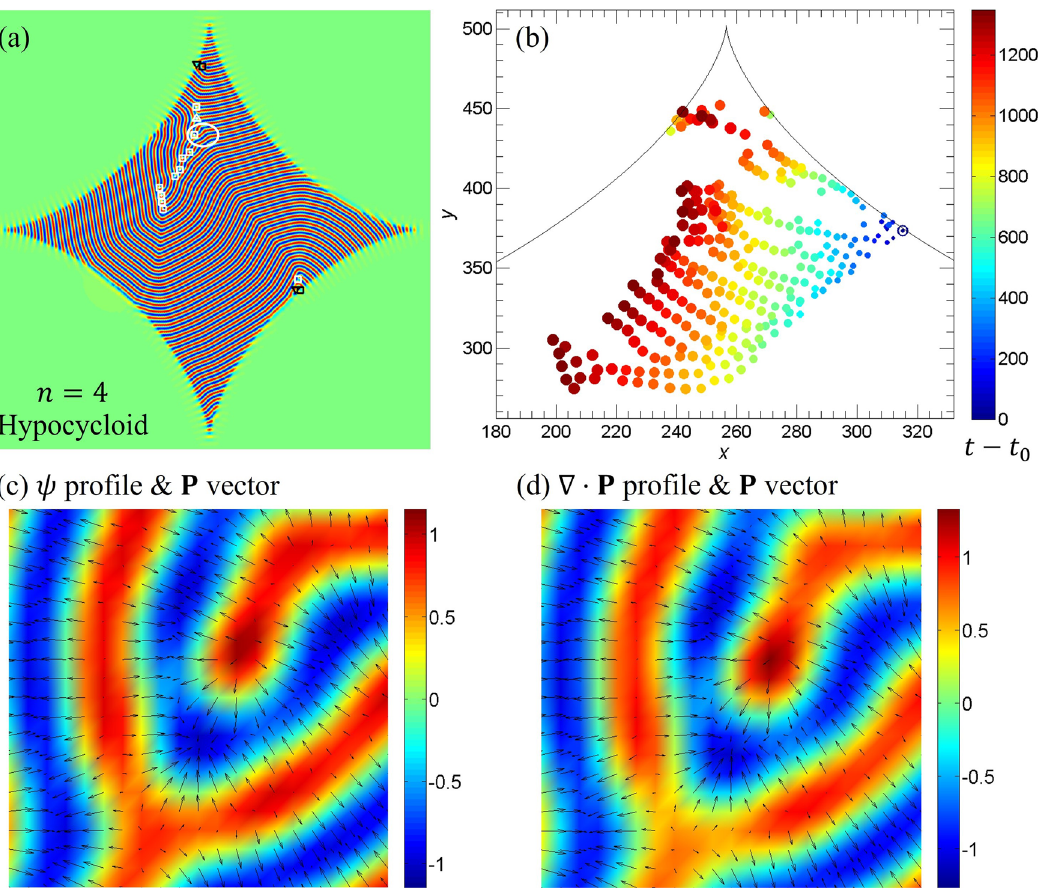
Fig. 5 Spatial pro fi les of ψ and S fi elds and defect trajectories in hypocycloid cavity. a Sample simulation snapshot of the density fi eld ψ pro fi le for a 4-cusp hypocycloid (astroid) cavity at v 0 = 0.31, with the labeling of defects. b Trajectories of defects in the upper part of the cavity, starting from a single defect (circled on the right) nucleated at the boundary at time t 0 = 198,650 up to the snapshot of ( a ) at t = 2 × 10 5 . Larger symbol size corresponds to later time, and samples for different time are also color-coded according to the color bar given on right. The hypocycloid boundary curve is also plotted. The corresponding time evolution of the pattern and defects can be found in Supplementary Movie 5. c Enlarged portion of the circled region in ( a ), with black arrows indicating the polarization vector fi eld P and the color bar showing the scale of density fi eld ψ . d The corresponding spatial pro fi le of the divergence fi eld S = ∇ ⋅ P , with P vector also shown as arrows and the scale of S fi eld indicated by the color bar. Note a small phase shift of this S fi eld pro fi le with respect to the ψ pro fi le in ( c ), which corresponds to a nonzero migration